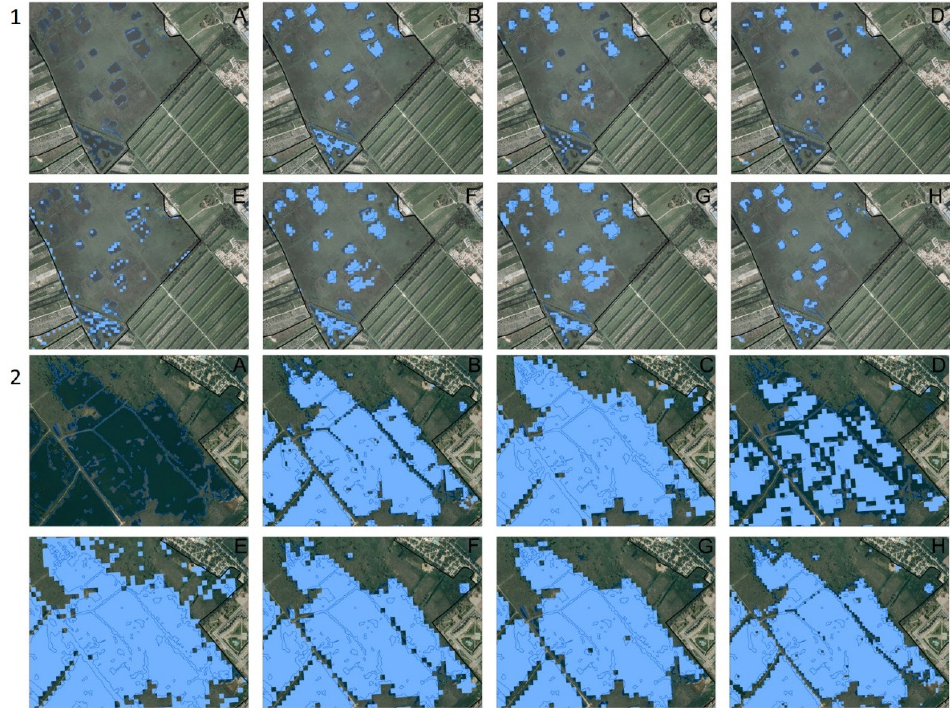
Figure 5. Delimited water bodies in two wetlands are represented: (1) Safor wetland 2017 and (2) Prat Cabanes-Torreblanca wetland 2018. ( A ): orthophoto, ( B ): NDWI index (threshold − 0.30), ( C ): mNDWI index (threshold − 0.35), ( D ): CEDEX index (threshold + 0.4), ( E ): Re-NDWI (threshold − 0.15), ( F ): Awei sh index (threshold − 1500), ( G ): Awei nsh index (threshold − 3000) and ( H ): NDWI / BLUE-NIR index (threshold −